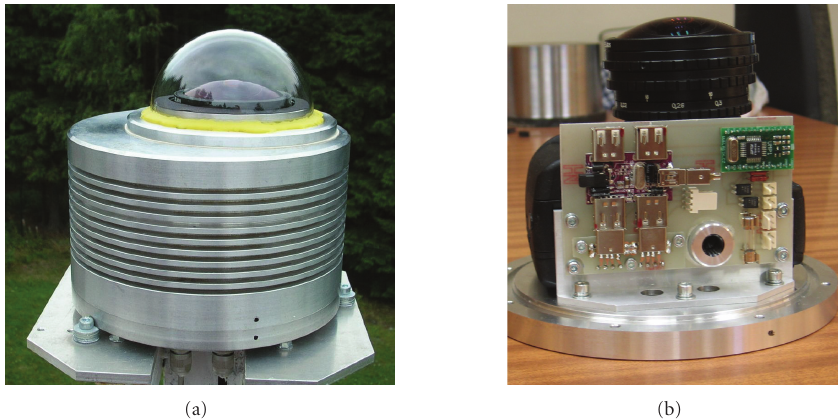
Figure 1: The assembled all-sky camera in observing conditions (a) and the camera with control electronic board (b).